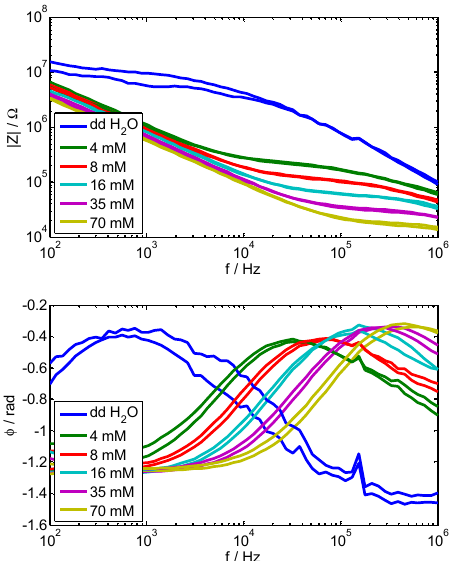
Fig.4: Magnitude and phase angle of a dilution series measured at one electrode pair (measurement and reference electrode) using the multiplexer.